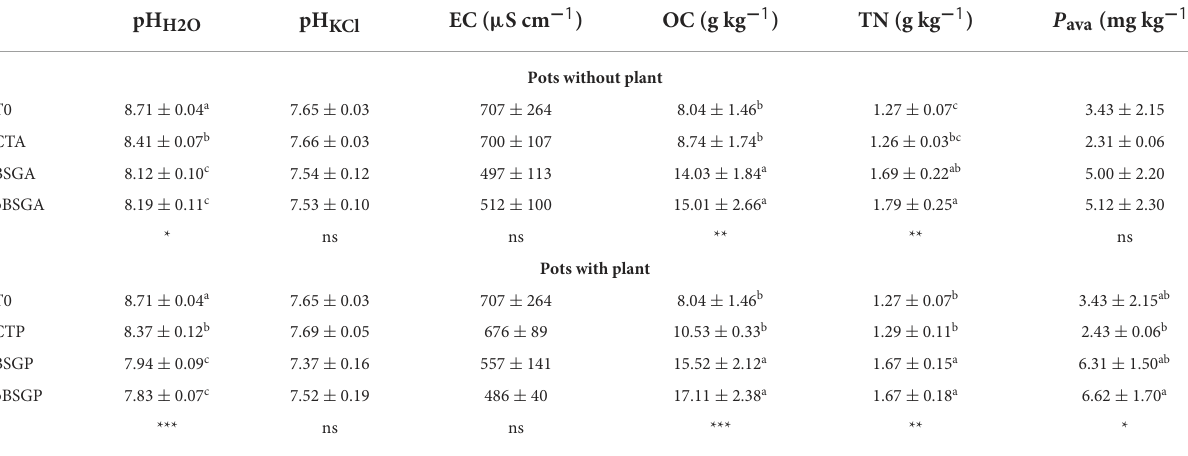
TABLE 2 Chemical and physicochemical properties of soils unamended (CT) and amended with native (BSG) or bioprocessed brewers’ spent grain (bBSG), uncultivated (A) or cultivated with escarole plants (P).